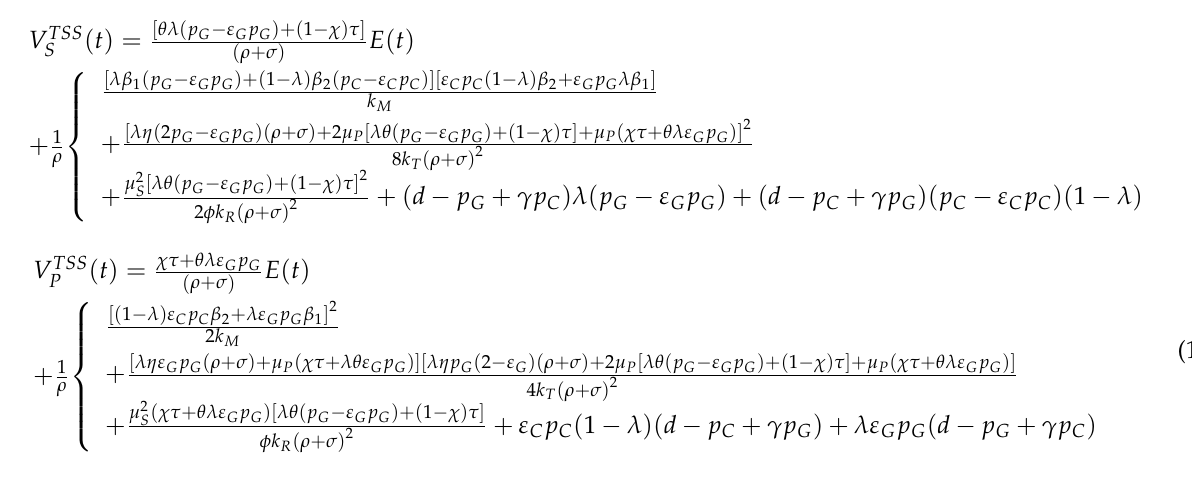
Table 1. Reasonable contract parameter region under the TSS model.